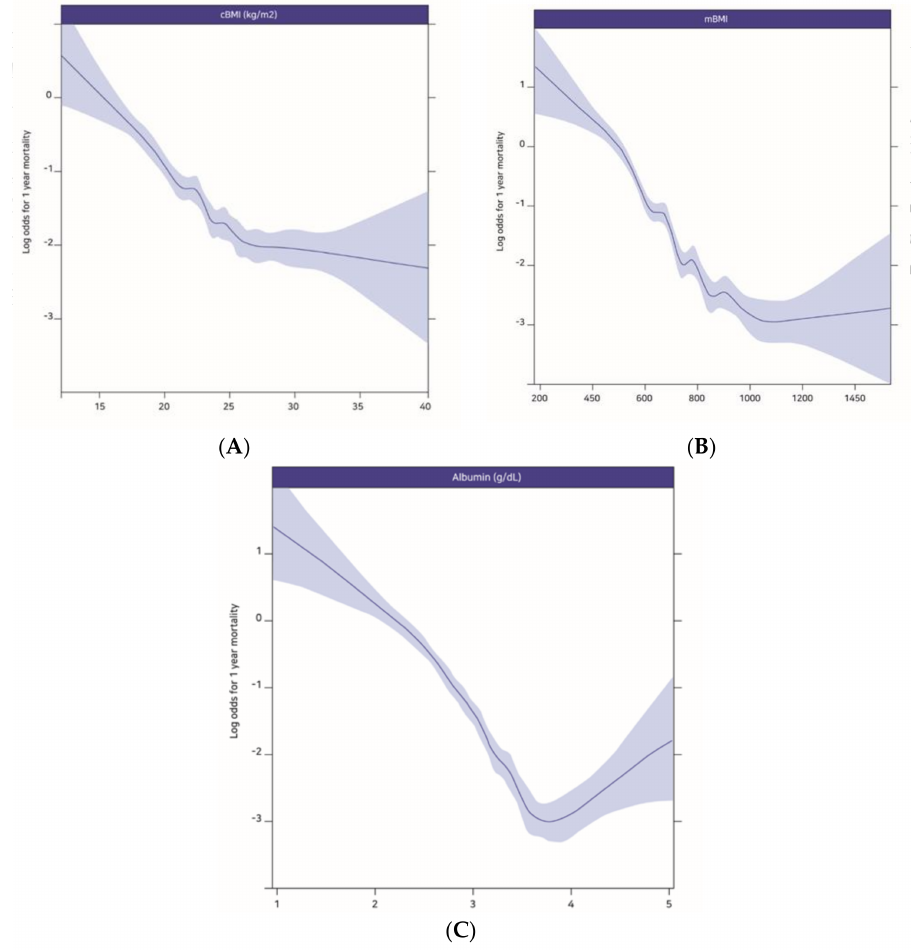
Figure 1. The log odds for 1-year mortality plotted against the changes in cBMI ( A ), mBMI ( B ) and albumin ( C ). cBMI: conventional BMI, mBMI: modified